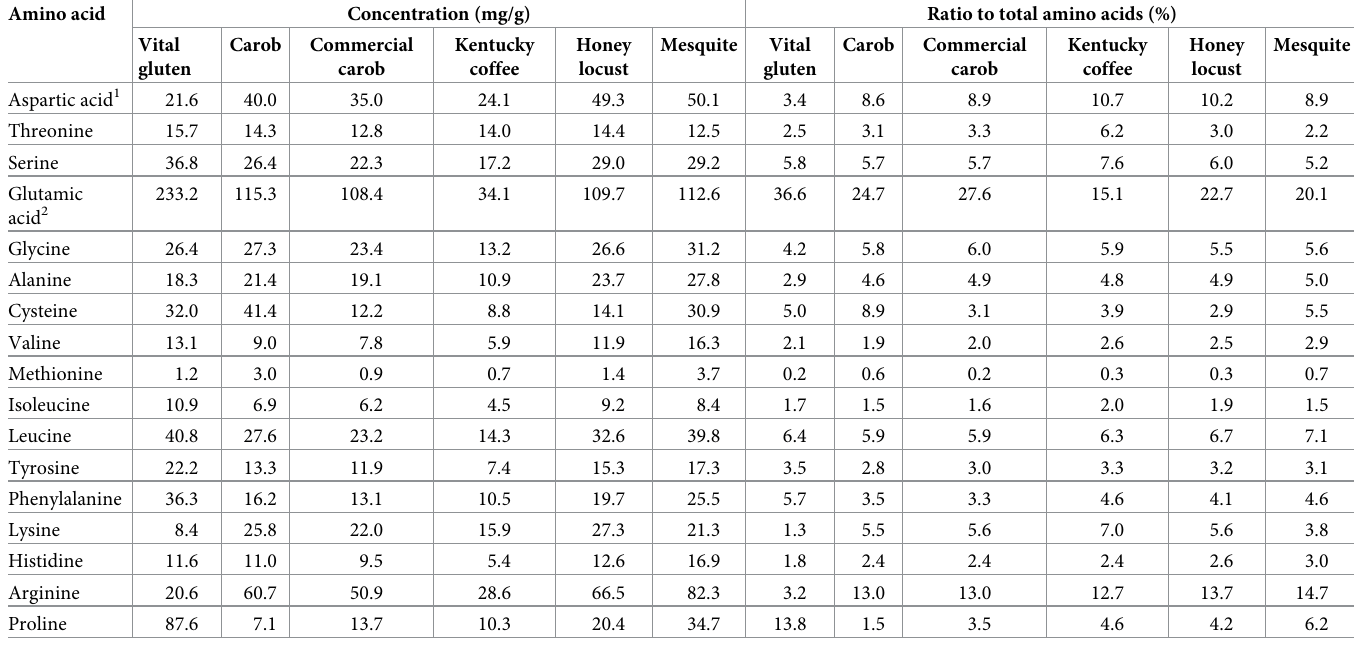
Table 2. The amino acid composition of all five samples (concentration and ratio) compared with